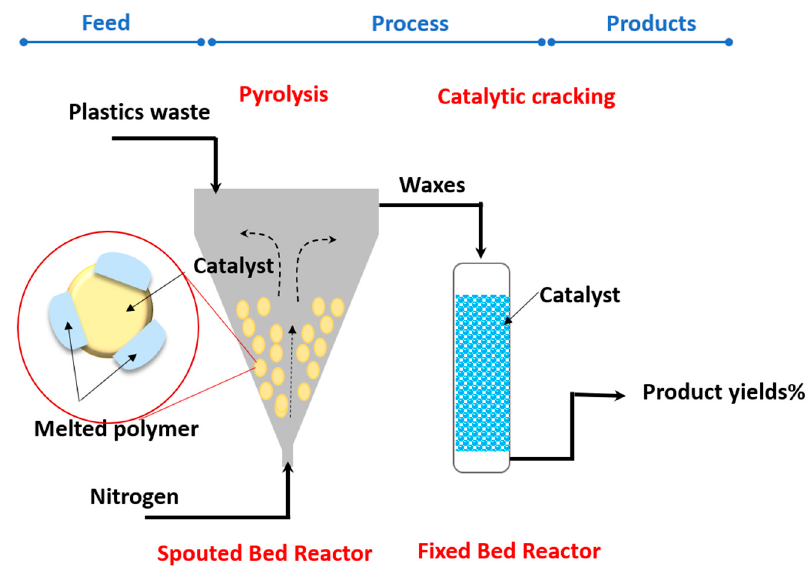
Figure 5. The illustration of combined pyrolysis reactor designs for improving the yields products.